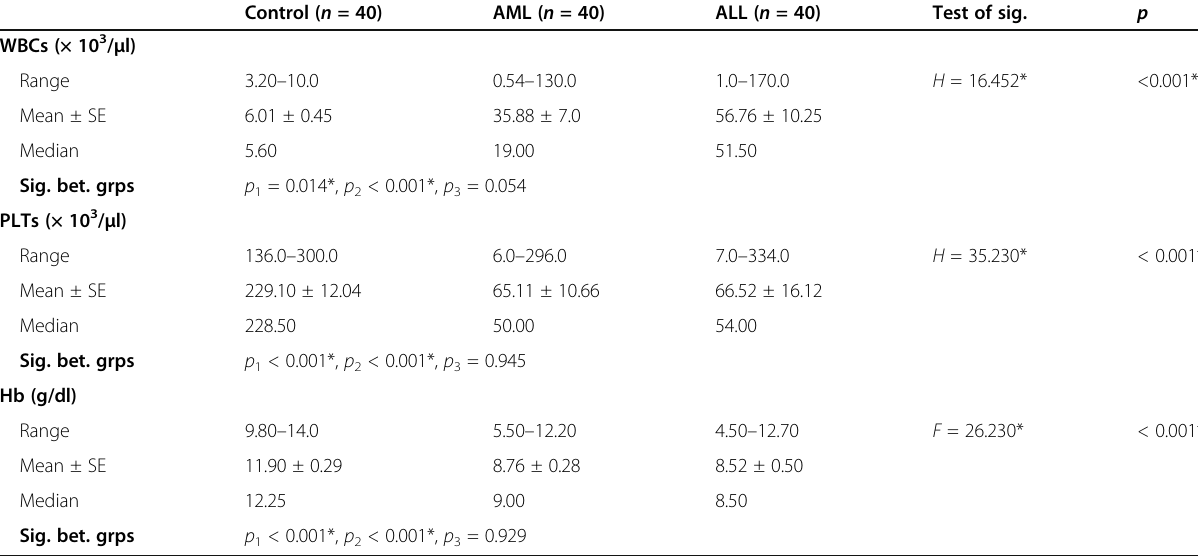
Table 5 Hematological parameters in AML and ALL patients and control group Control ( n = 40) AML ( n = 40) Test of